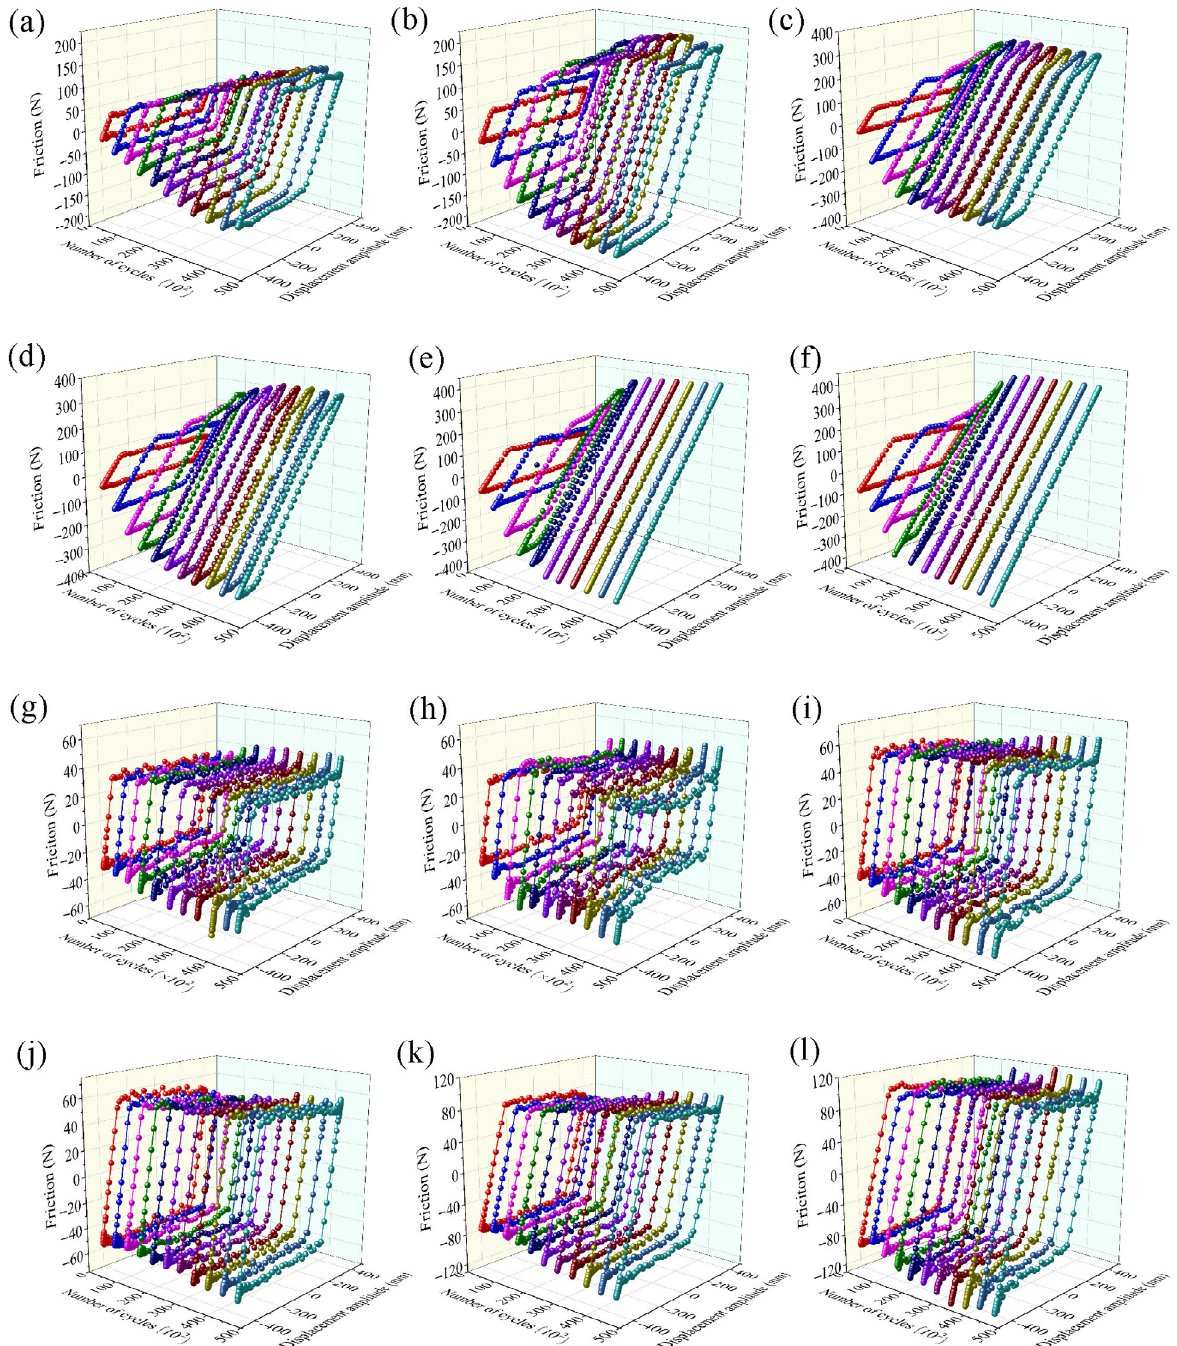
Fig. 12 Evolution of hysteresis curves for different twist angles and lateral loads under dry friction conditions. (a–f) Dry friction, (g–l) oil lubrication. Loading conditions: (a) 4.2° + 80 N, (b) 4.2° + 160 N, (c) 5.4° + 80 N, (d) 5.4° + 160 N, (e) 5.6° + 80 N, (f) 5.6° + 160 N, (g) 4.2° + 80 N, (h) 4.2° + 160 N, (i) 5.4° + 80 N, (j) 5.4° + 160 N, (k) 5.6° + 80 N, and (l) 5.6° + 160